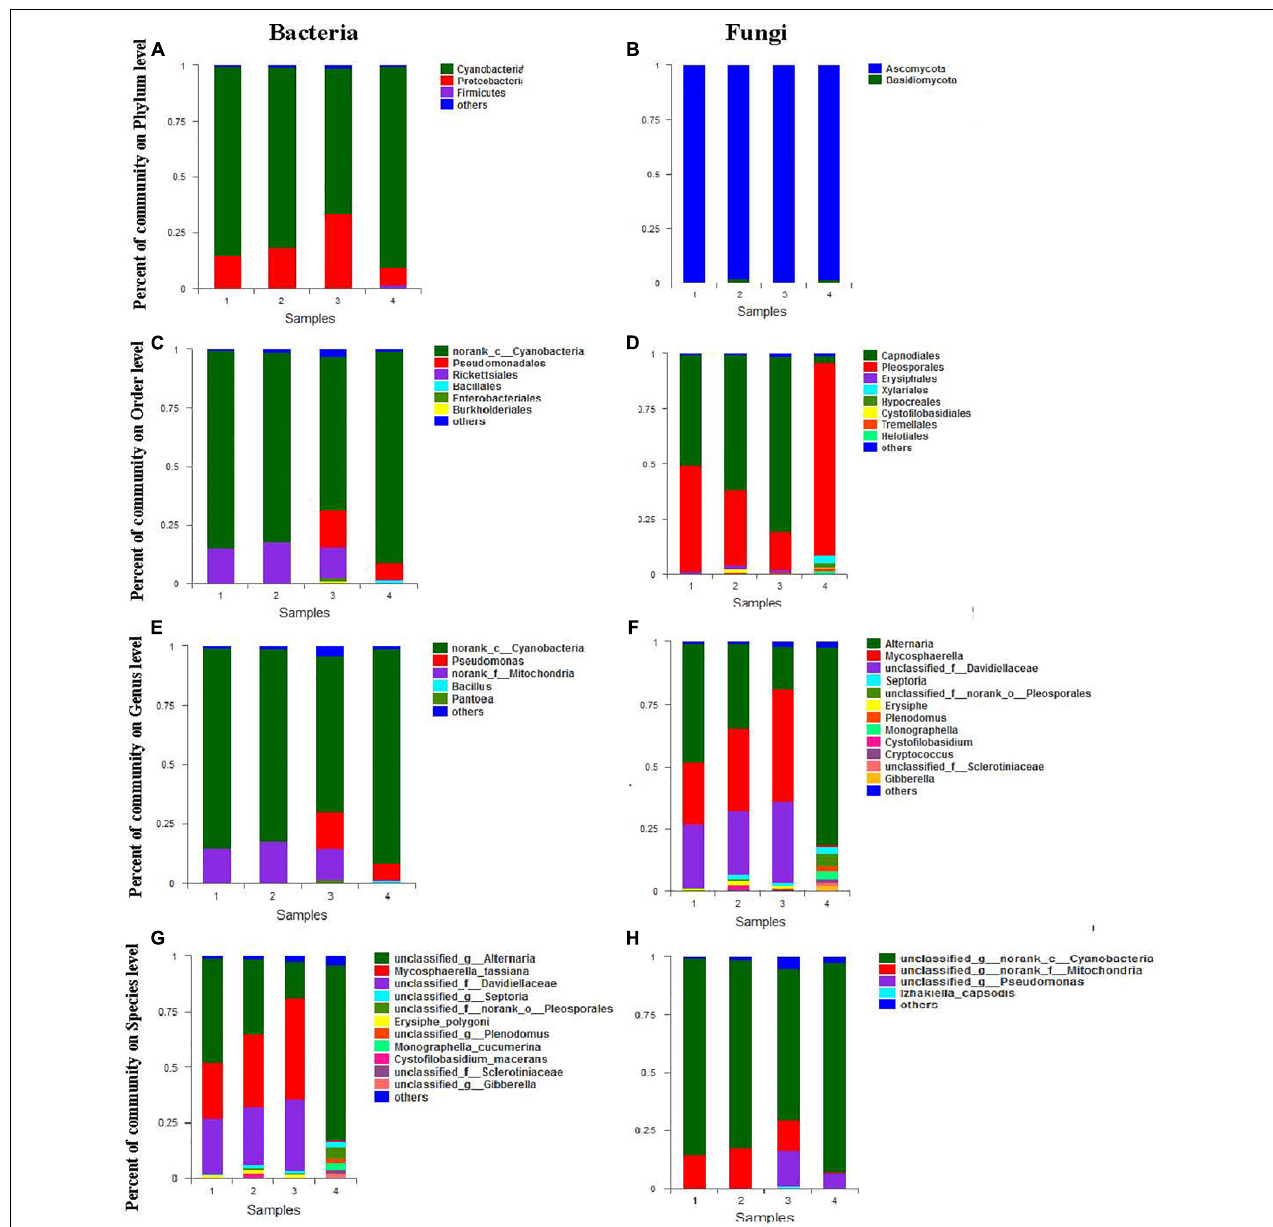
FIGURE 2 | Mean relative abundance of the abundant phyla, orders, genera, and species in bacteria (A,C,E,G) and fungi (B,D,F,H)